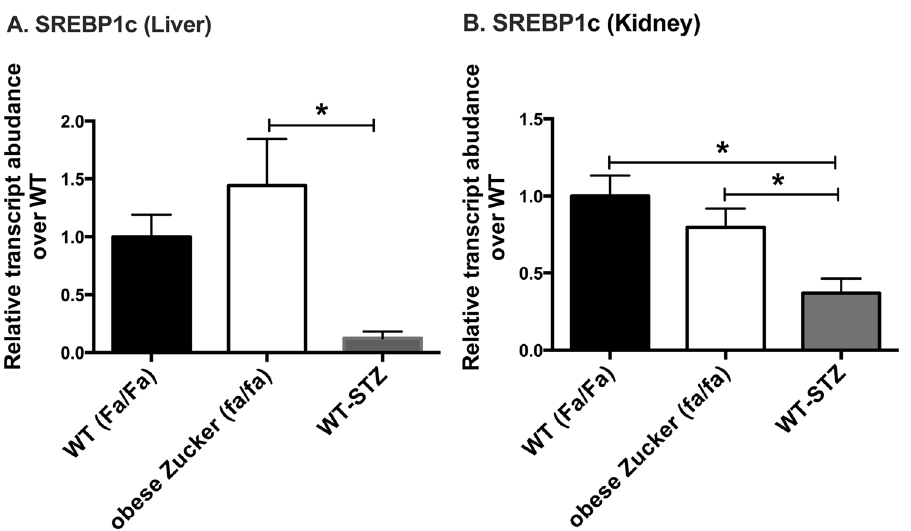
Figure 5. Hepatic ( A ) and renal ( B ) expression levels of SREBP-1c measured using rtPCR. Measurements were obtained in liver and kidney tissue samples from age and sex matched WT (Fa/Fa) (n = 4), obese Zucker (fa/fa) (n = 9), and WT-STZ (n = 6) rats. The fold changes were measured relative to WT (Fa/Fa) controls and calculated by 2 −Δ Ct method. The data were normalized to β -actin. All data represent mean + / − S.E.M. from three independent experiments. Statistical analysis was performed by one-way ANOVA with Tukey correction for multiple comparisons. ( * p <